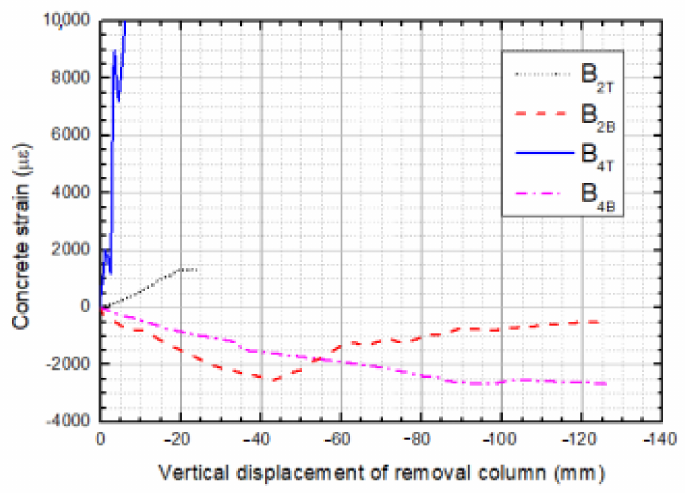
Figure 12. Concrete strain at B2 and B4.